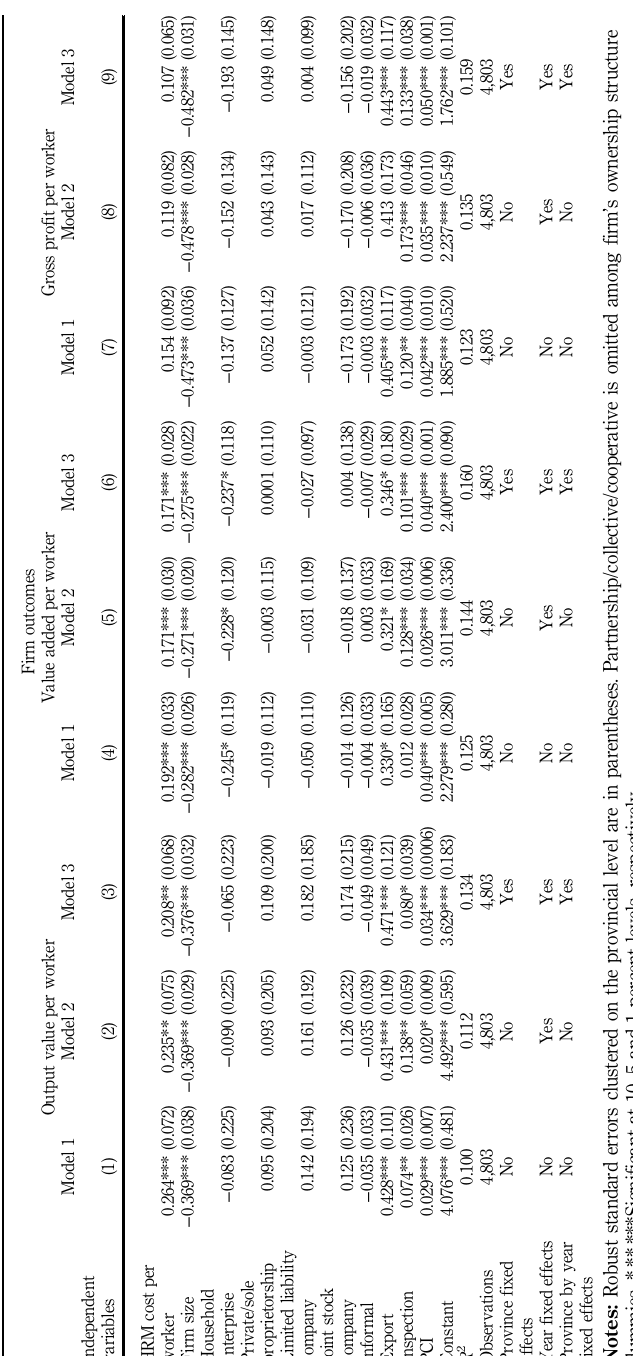
Table V. HRM spending and firm